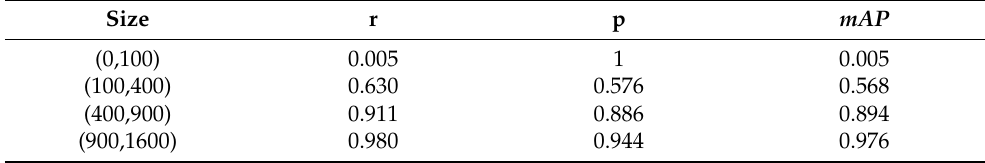
Table 2. Evaluation results of targets in different scales in LS-SSDD-v1.0 using Double-Head R-CNN. Size r p mAP (0,100) 0.005